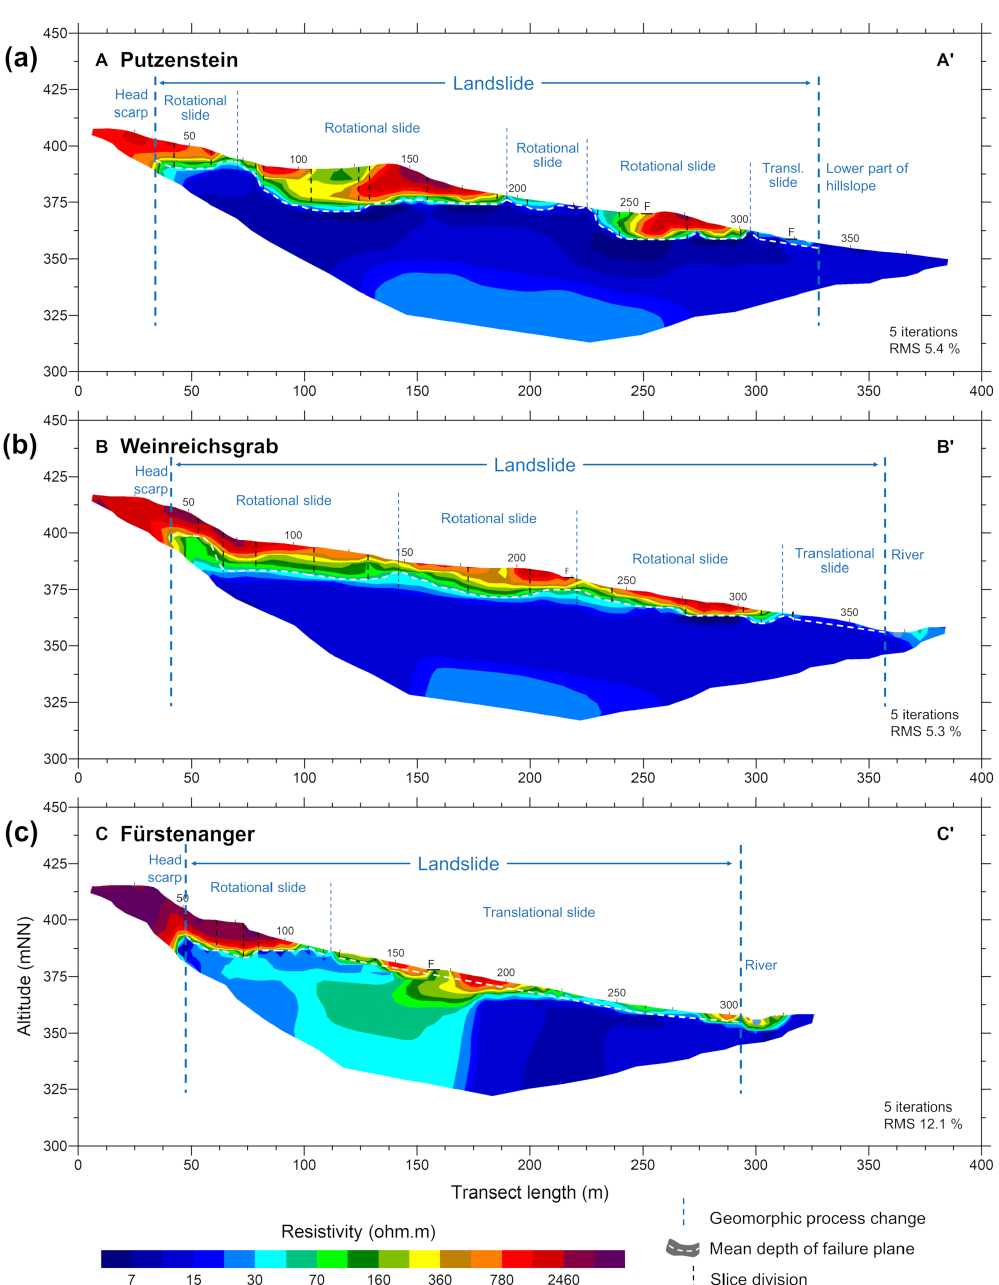
Figure 5. Geoelectric models and landslide forms at (a) Putzenstein, (b) Weinreichsgrab and (c) Fürstenanger. Failure plane depth was derived from a vertical resistivity decrease of 1 to 2 orders of magnitude. For the detailed derivation, see Fig. S3. F highlights the location of forest